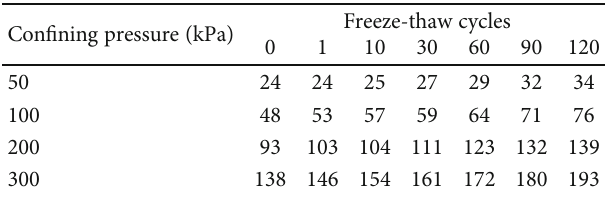
Table 5: Pore water pressure in undrained shear failure of specimens under di ff erent